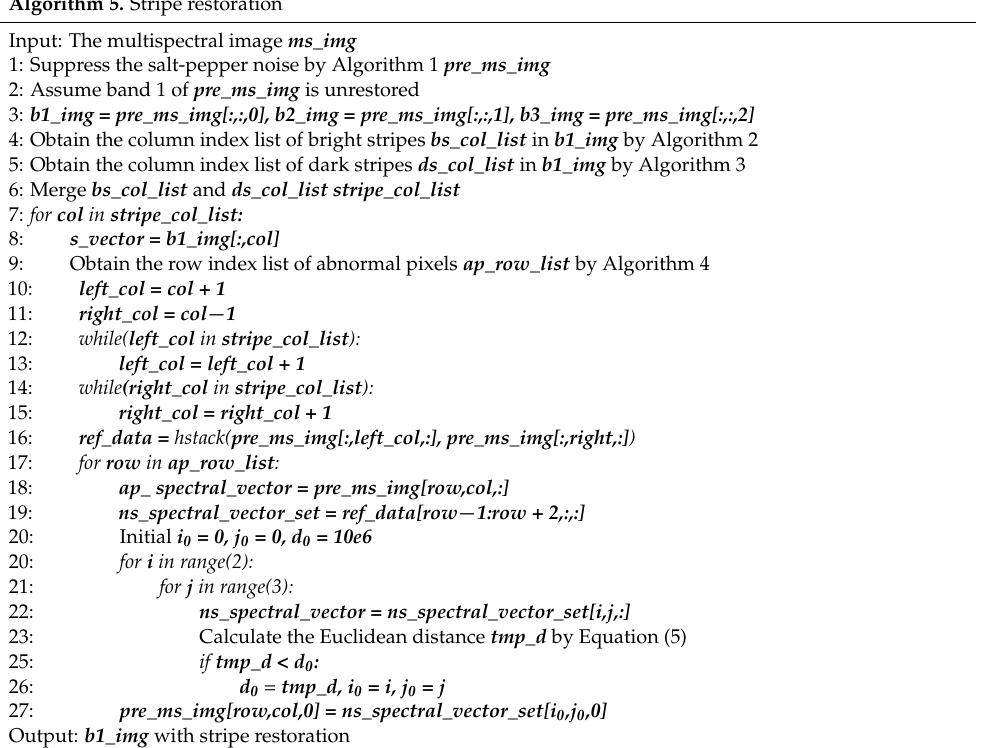
Algorithm 5. Stripe